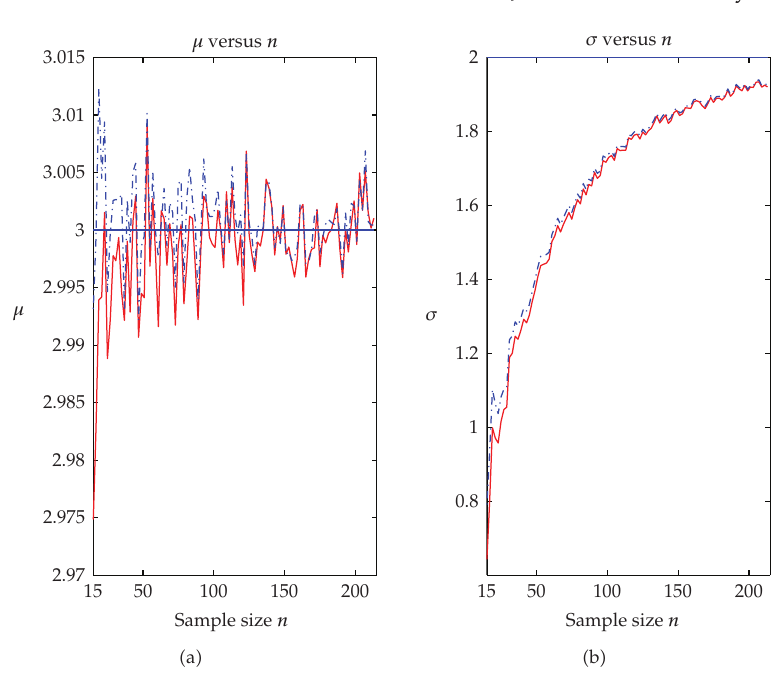
Figure 6: Grouped data: τ 1 (cid:8) − 3 . 5, τ 2 (cid:8) − 0 . 5, τ 3 (cid:8) 2 . 5, τ 4 (cid:8) 5 . 5, τ 5 (cid:8) 8 . 5. Type I left censored data: τ (cid:8) − 3 . 5 .